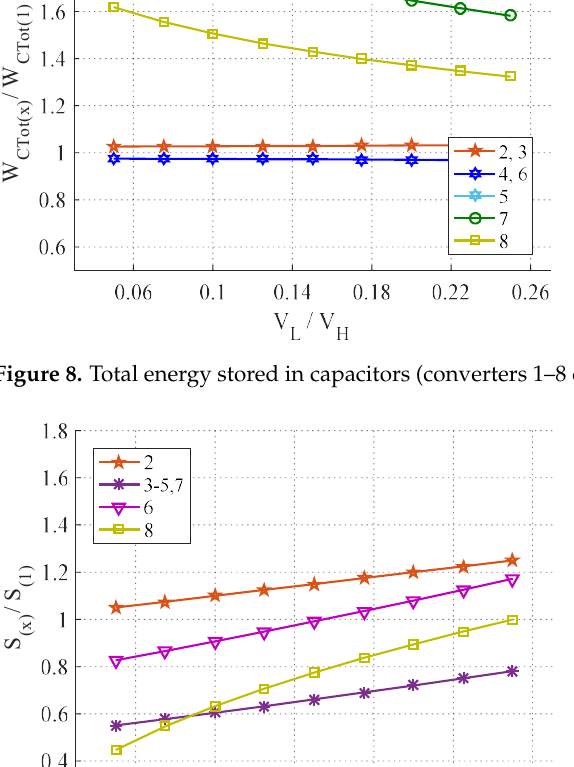
Figure 9. Total active switch stress, as function of the voltage conversion ratio (Converters 1–8 described in Table 1).